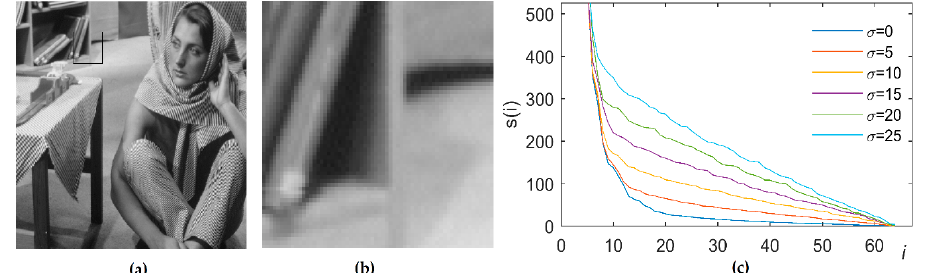
Figure 1. (a) The test image “Barbara”. The boundary of a 64 × 64 image patch is shown; (b) a magnified image patch; (c) the singular value curves corresponding to the image patch degraded by different levels of Additive White Gaussian Noise (AWGN).